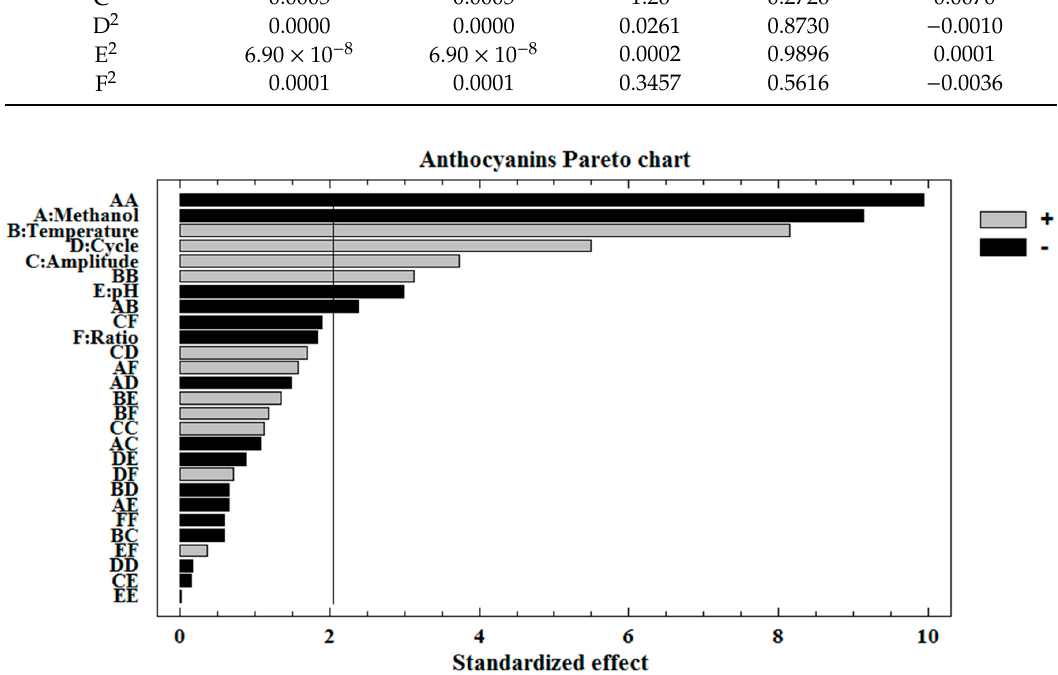
Figure 3. Standardized Pareto Charts for total anthocyanins.